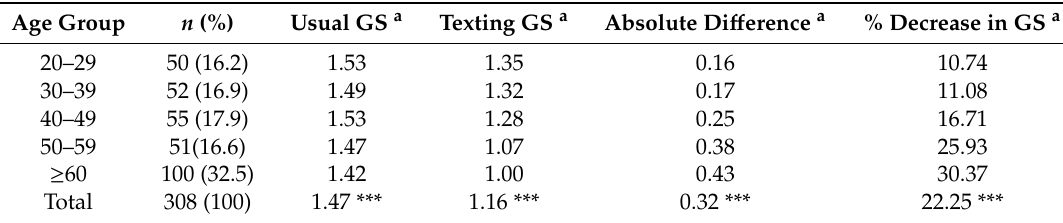
Table 2. Di ff erence in gait speed by age